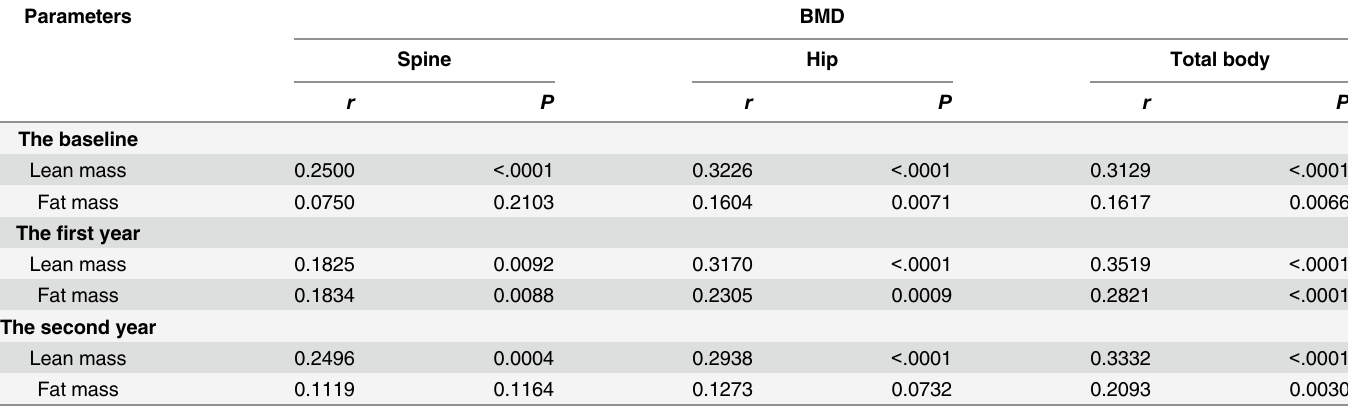
Table 3. Partial correlation of BMD of the spine, hip, and the total body with body composition at baseline and follow-up (adjusting for height and calcium supplementation). Parameters